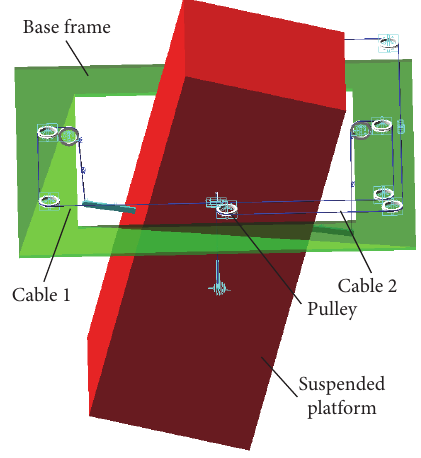
Figure 3: ADAMS simulation